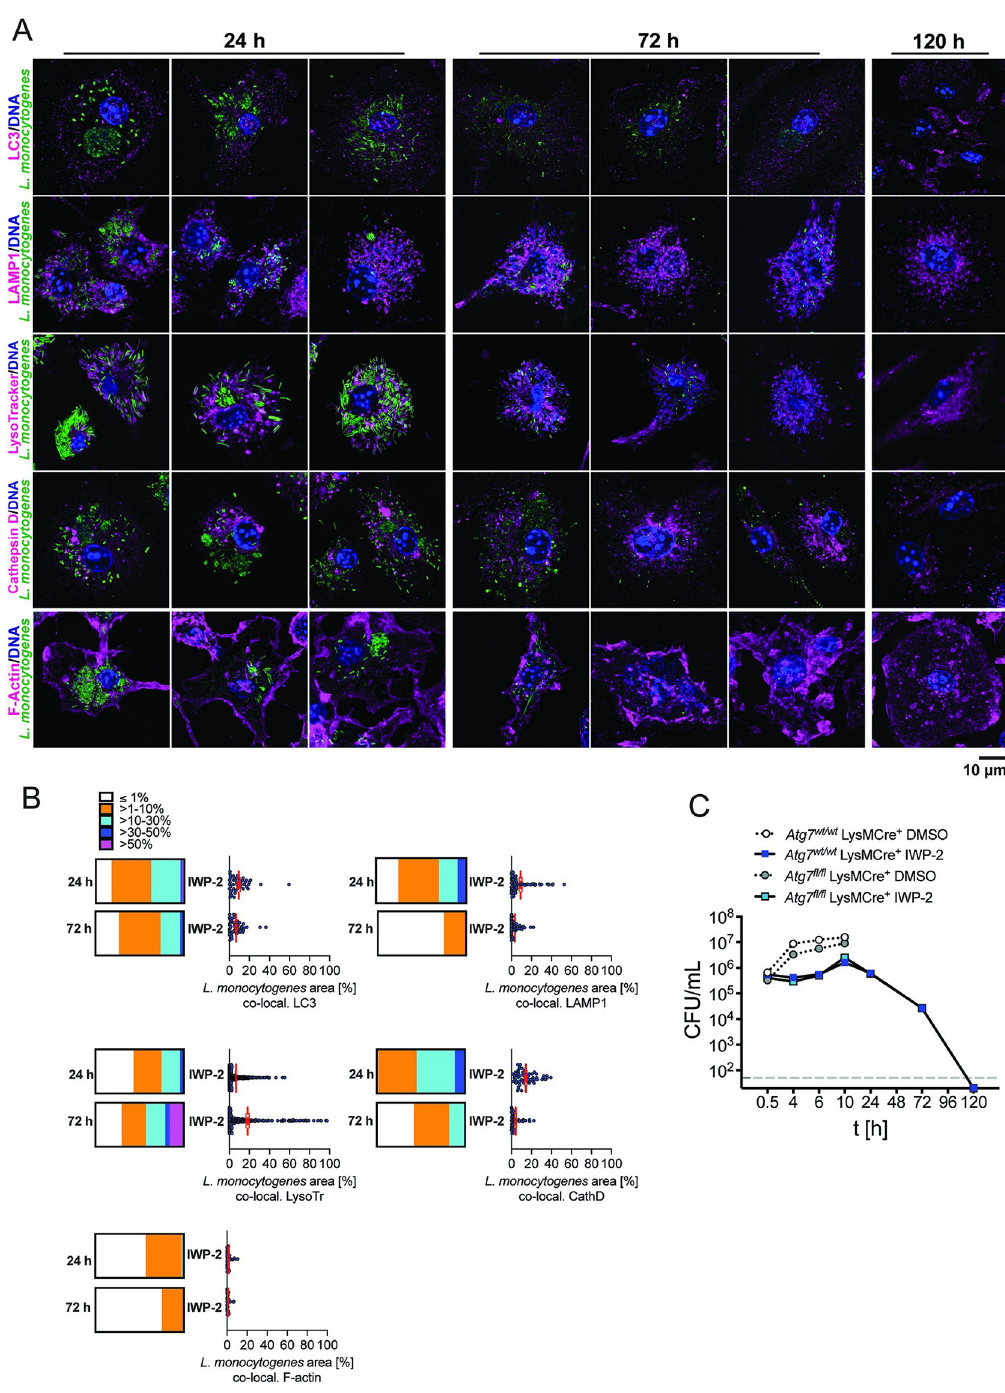
Fig 6. Progressive elimination of L . monocytogenes from spacious replication vacuoles in infected macrophages is associated with acquisition of lysosomal features independent of autophagy. (A) Spinning-disk confocal fluorescence microscopy of mouse bone marrow-derived macrophages (BMM) infected with L . monocytogenes in the presence of IWP-2 (10 μ M) at 24, 72, 120 h post-infection. Cells were co-stained for LC3, LAMP1, acidified (LysoTracker) and cathepsin D- positive, lysosomal compartments, and filamentous (F-) actin (scale bar 10 μ m). Images are representative of at least 6 independent experiments. (B) Co-localization of total L . monocytogenes signal per cell with signal for each cellular marker. Scatter plots are data points from 83–108 cells per condition analyzed cumulatively across 3 independent experiments; means +/- sem. Box plots are binned data: � 1%, > 1–10%, > 10–30%, > 30–50%, > 50% of L . monocytogenes signal per cell